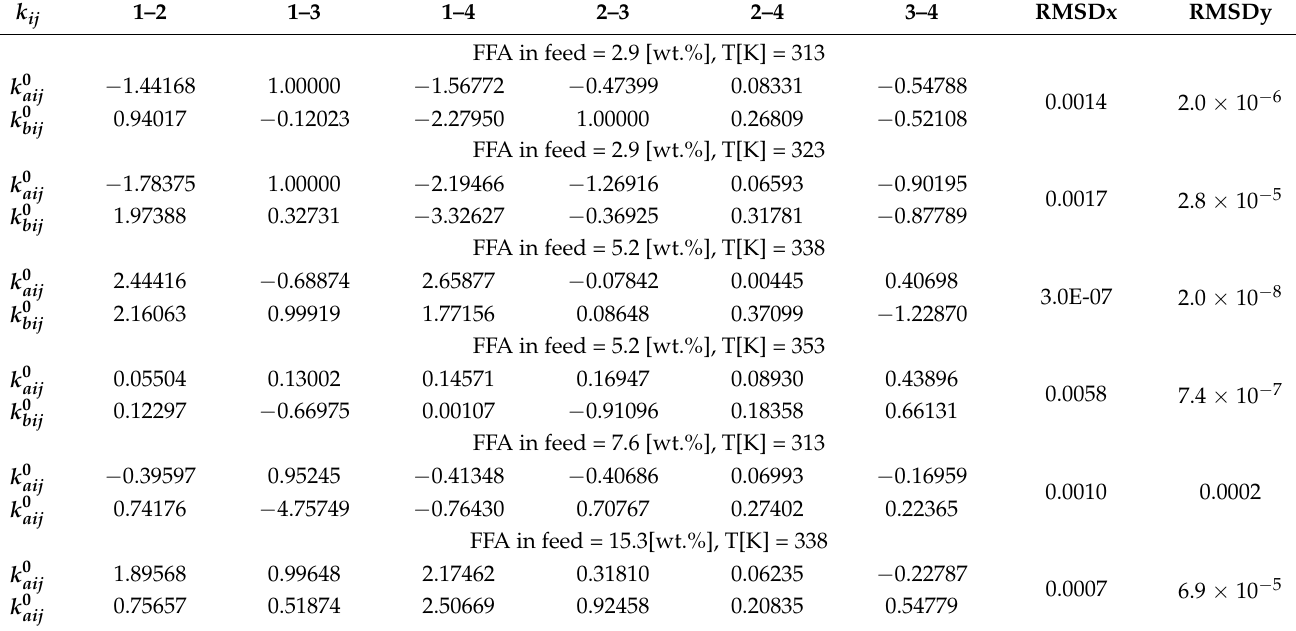
Figure 4. Experimental and predicted high-pressure phase equilibrium for the system triolein-CO 2 (Weber et al., 1999). Simulation Modeling for the Model System Olive Oil Key (Oleic Acid-Squalene-Triolen-CO 2 Because high-pressure phase equilibrium data for the complex system OLP-CO 2 is not available in the literature, the proposed methodology tested to simulate the thermodynamic modeling by de-acidification of olive oil, represented by a quaternary model mixture oleic acid-squalene-triolein-CO 2 . Table 13 presents the RK-Aspen EOS temperature independent binary interaction pa- rameters adjusted to the experimental high-pressure equilibrium data for the multicompo- nent olive oil-CO 2 , described in Table 14 [90], and represented in this work as a multicompo- nent model mixture oleic acid-squalene-triolein-CO 2 . In addition, Table 13 presents the root- mean-square deviation (RMSD) between the multicomponent experimental high-pressure equilibrium data and the computed results for the coexisting gaseous-liquid phases. The State conditions (T, P) by the experimental high-pressure equilibrium data for the multicomponent olive oil-CO 2 , described in Table 14. Table 15 presents the average absolute deviation (AAD) between the predicted and experimental high-pressure phase equilibrium data for the model systems oleic acid(1)- Table 13. RK-Aspen EOS temperature-independent binary interaction parameters adjusted with experimental high-pressure phase equilibrium data for the model systems oleic acid(1)-squalene(3)-triolein(2)-CO 2 (4). k